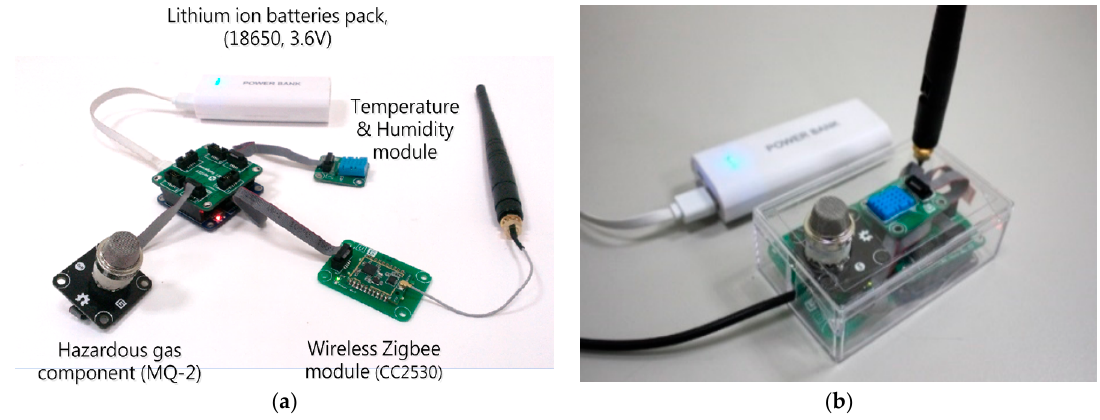
Figure 6 . The developed sensor node ( a ) disassembled; ( b ) compacted.